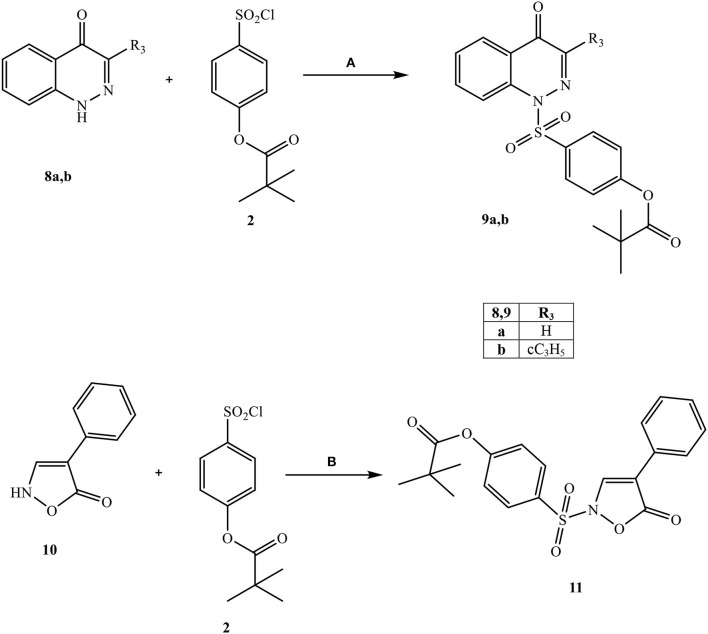
aReagents and conditions. (A) Et3N, anhydrous CH2Cl2, 0°C, 2 h then r.t., 2 h; (B) dry pyridine, r.t., 4 h.